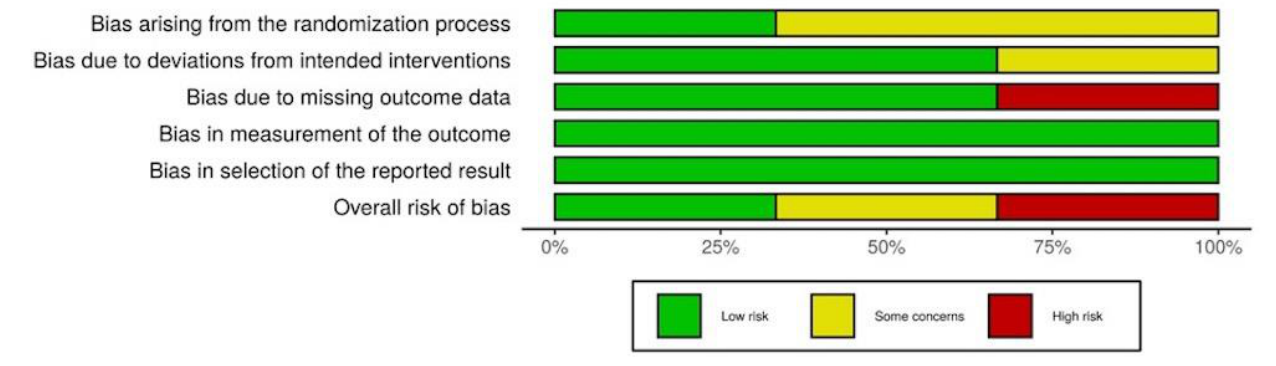
Figure 3. Risk of bias of randomized controlled trials.